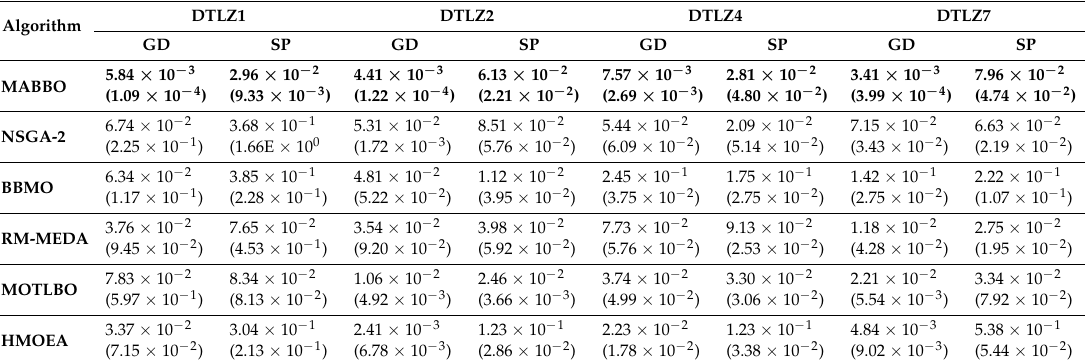
Table 3. Comparison on 3-objective test problems